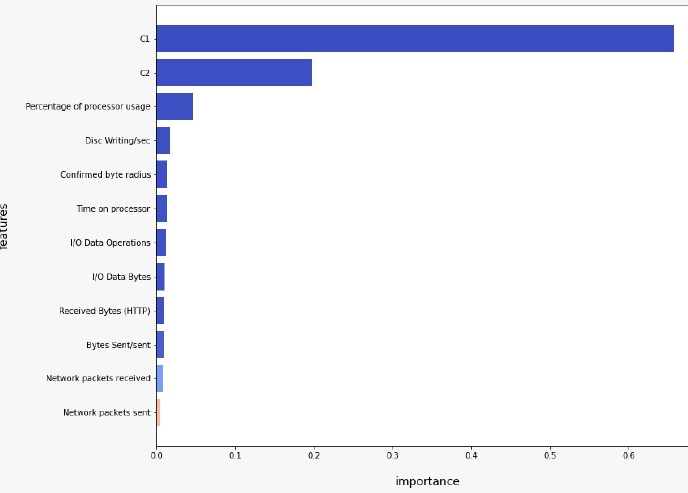
Figure 6. Feature importance XGBoost